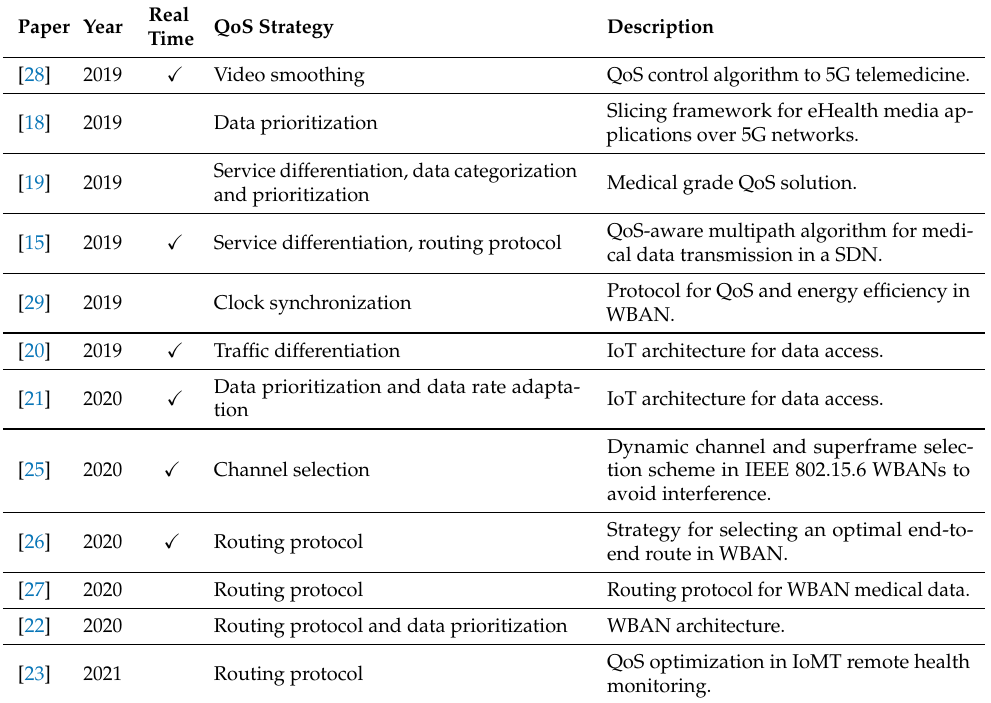
Table 1. Summary of the research and QoS strategies in healthcare solutions.